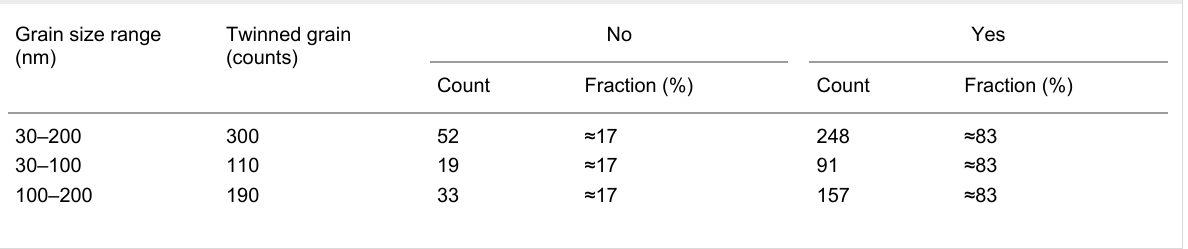
Table 1: Statistical data of triple junction related twinning. Yes and No in this table denote whether a twin (boundary or domain) is connected to a triple junction. Grain size range (nm)